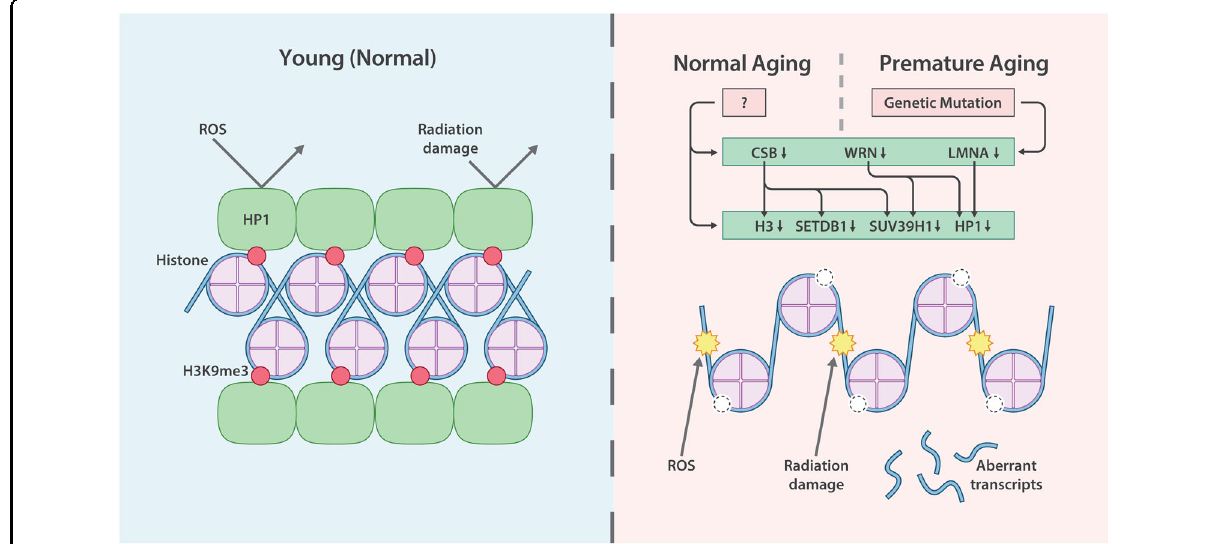
Fig. 1 Overview of heterochromatin loss during aging. In young and healthy individuals, cells exhibit intact heterochromatin, a high level of H3K9me3, and a high level of HP1 bound to H3K9me3, which are factors that stabilize the heterochromatin complex. However, both chronologically and prematurely aged cells show decreased expression of core histones and reduced levels of H3K9me3 and HP1. CSB, WRN, and LMNA de fi ciency leads to H3, SETDB1, SUV39H1, and HP1 dysregulation, resulting in heterochromatin loss, DNA damage accumulation, and the expression of aberrant transcripts. The mechanisms under the decreased expression of CSB, WRN, and LMN with normal aging remain